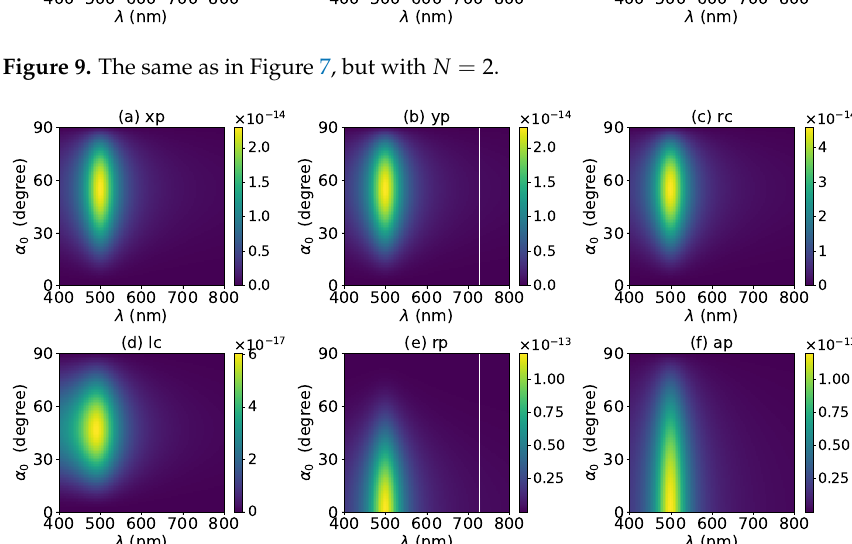
Figure 9. The same as in Figure 7, but with N = 2.